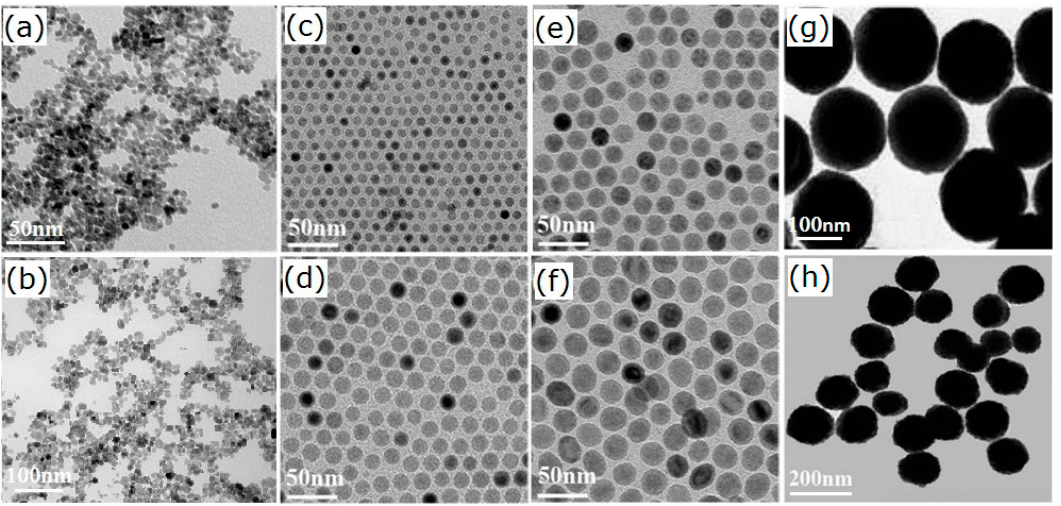
Figure 1. Transmission electron microscope (TEM) images of Fe 3 O 4 NPs prepared by ( a,b ) co-precipitation method [23,44]; ( c – f ) thermal decomposition method [50]; and solvothermal method ( g ) as in [54], ( h ) as in [39].